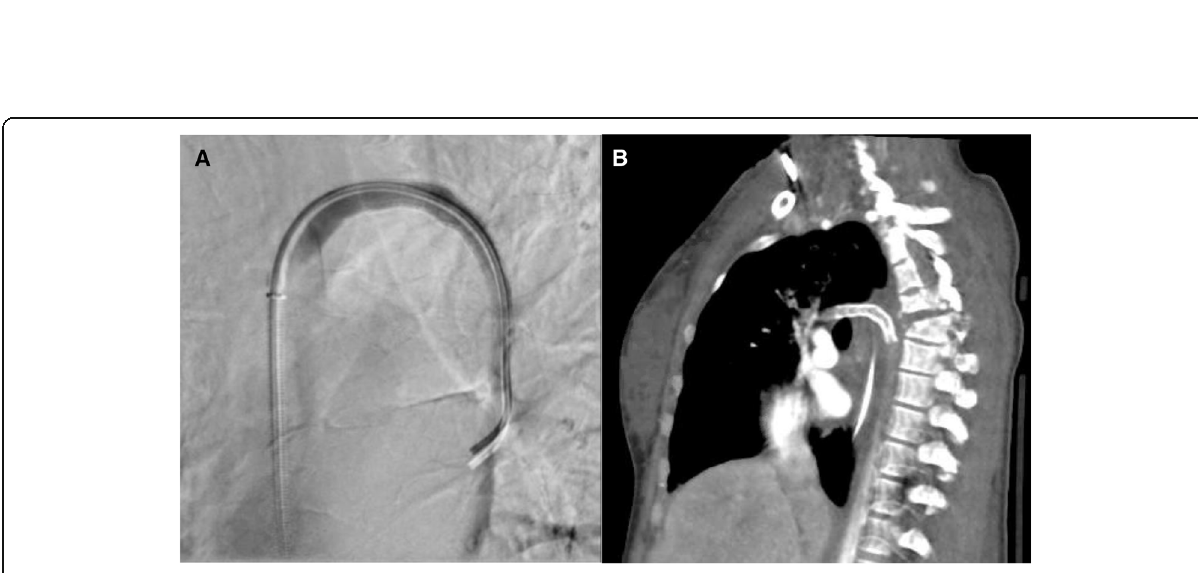
Fig. 3 A Post procedural DSA confirms no extravasation after Viabahn stent graft placement. B CT (sagittal oblique view) performed on post- procedure day eight, though suboptimally timed for venous evaluation, shows no evidence of hematoma, hemorrhage, or other stent